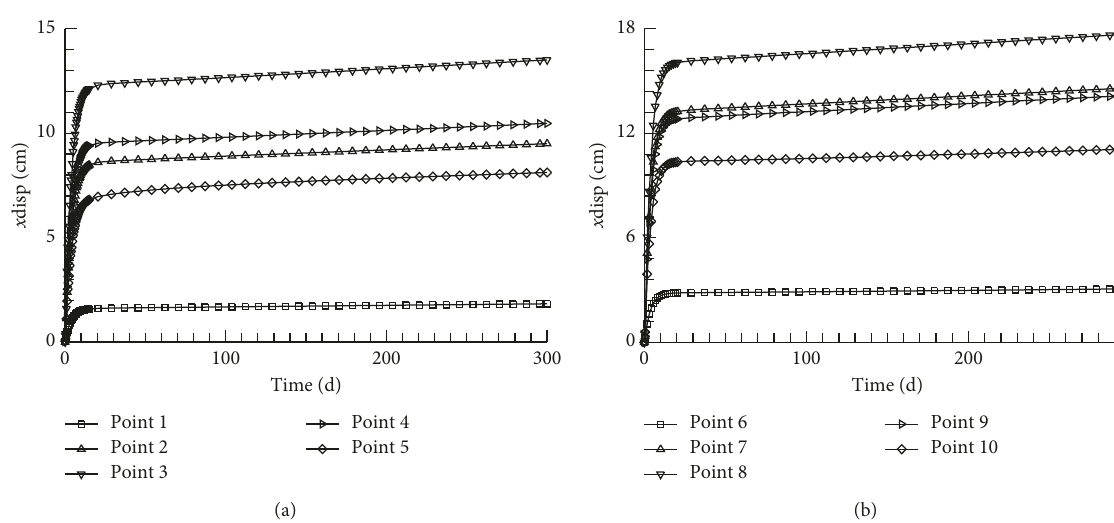
Figure 10: Curve of the horizontal displacement of the key points over time in (a) the slip surface and (b) the slip body.